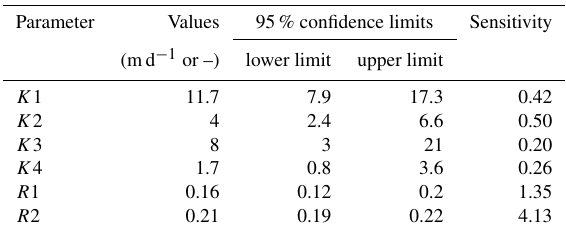
Table 1. The automatically calibrated values of hydraulic conduc- tivities and recharge infiltration ratios and their respective sensitivi- ties to observed